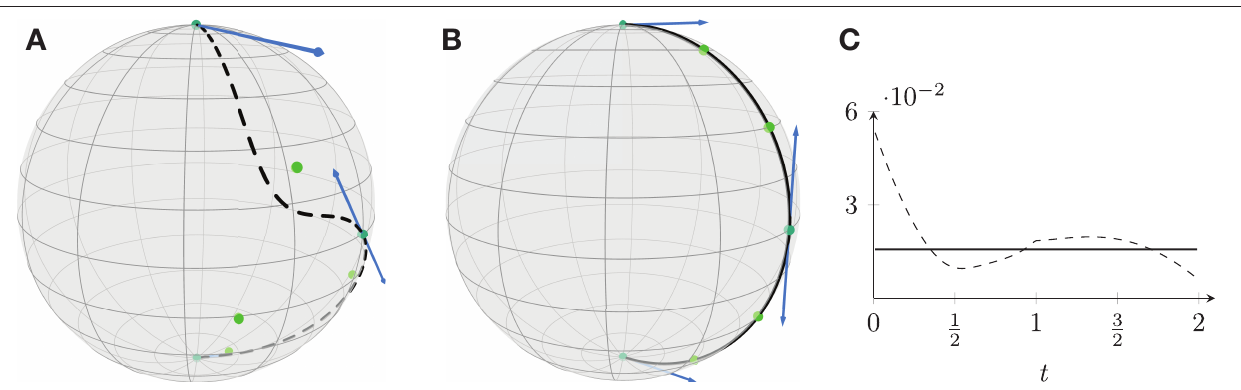
10 (violet, B ) to λ 0.01 (yellow, B ). The limit case where λ = =